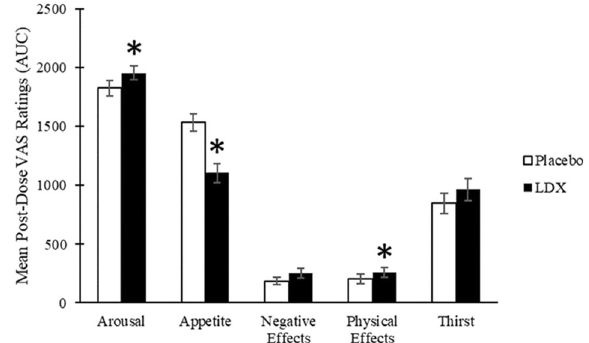
Fig. 3 Visual analogue scales (VAS) ratings presented as means for area under the curve (AUC) for the placebo (open bars) and LDX ( fi lled bars) conditions. Error bars represent the standard error of the mean. Asterisks denote signi fi cantly different from placebo ( p < 0